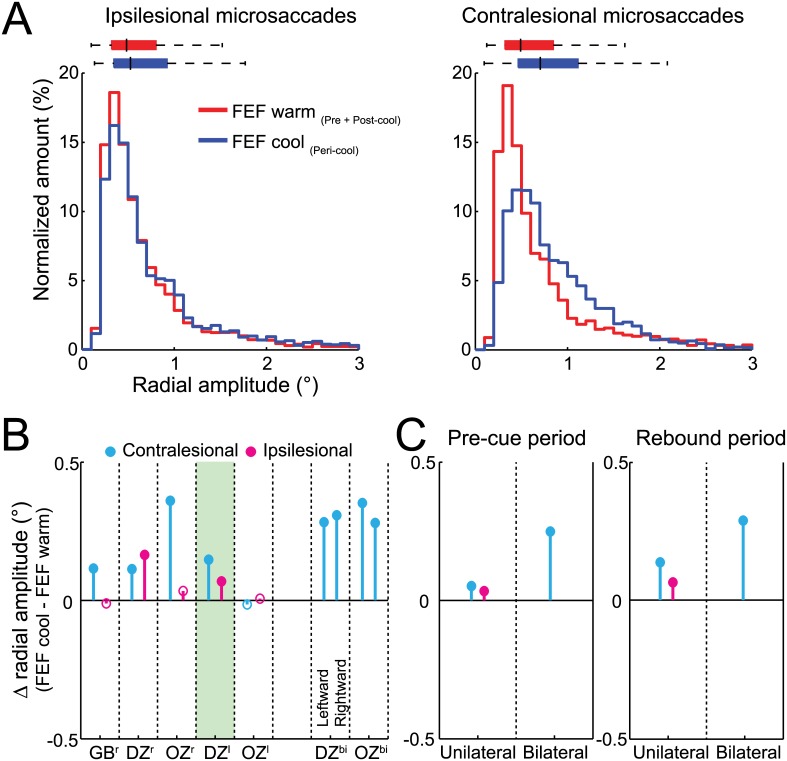
FEF inactivation increased ipsilesional and contralesional microsaccade amplitudes independently of peripheral cueing.(A) Unilateral (left) FEF inactivation shifted distributions toward larger amplitudes for each microsaccade direction from example monkey DZ, although we observed larger increases for contralesional microsaccades. Colored bars above the distributions indicate the median, with 25th and 75th percentiles with whiskers extending outward to the 1st and 99th percentiles. (B) Microsaccade amplitudes increased for each monkey (GB, DZ, and OZ) and unilateral (Xr or Xl) or bilateral (Xbi) inactivation configurations, but unilateral FEF inactivation more consistently increased contralesional amplitudes. The shaded area in B indicates microsaccades from our example monkey. (C) Across monkeys, unilateral or bilateral FEF inactivation increased microsaccade amplitudes in both the pre-cue (left) and rebound (right) periods. Filled symbols in B and C indicate statistically significant differences using a Wilcoxon rank sum test (p < 0.05). Data in Supporting Information (see S1 Data).